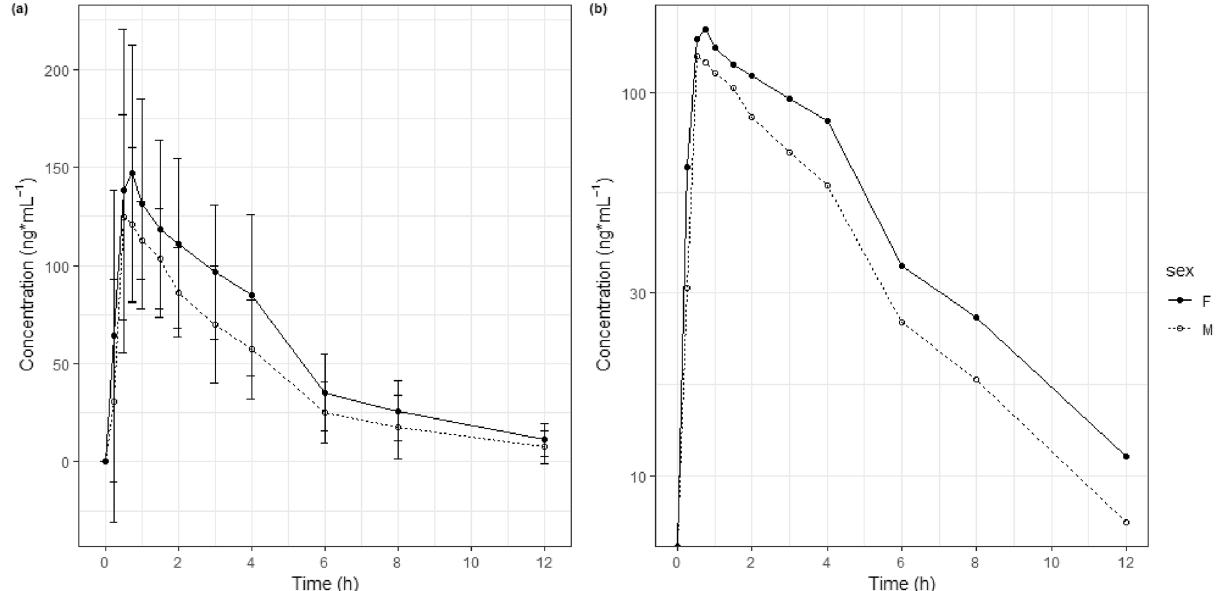
Figure 1. Mean plasma concentration–time profiles of zolpidem. ( a ) Linear scale, ( b ) log-scale. Female: Closed circle-solid line; Male: Open circle-dotted line, Bars represent standard deviation.